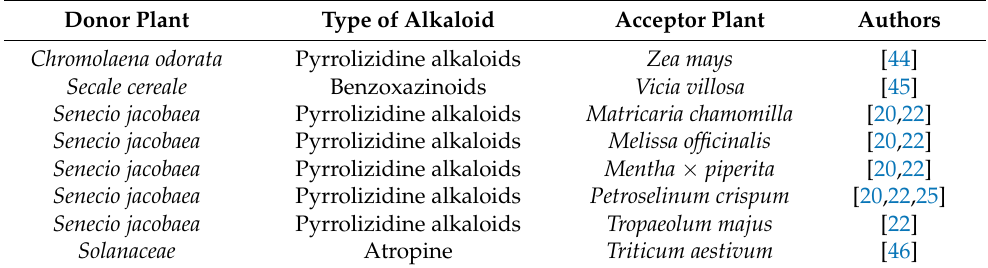
Figure 1. Horizontal natural product transfer. The scheme displayed by Selmar et al. [26] is supple- mented with the processes occurring in the rhizosphere. Table 1. Transfer of alkaloids via soil between vital donor and acceptor plants.